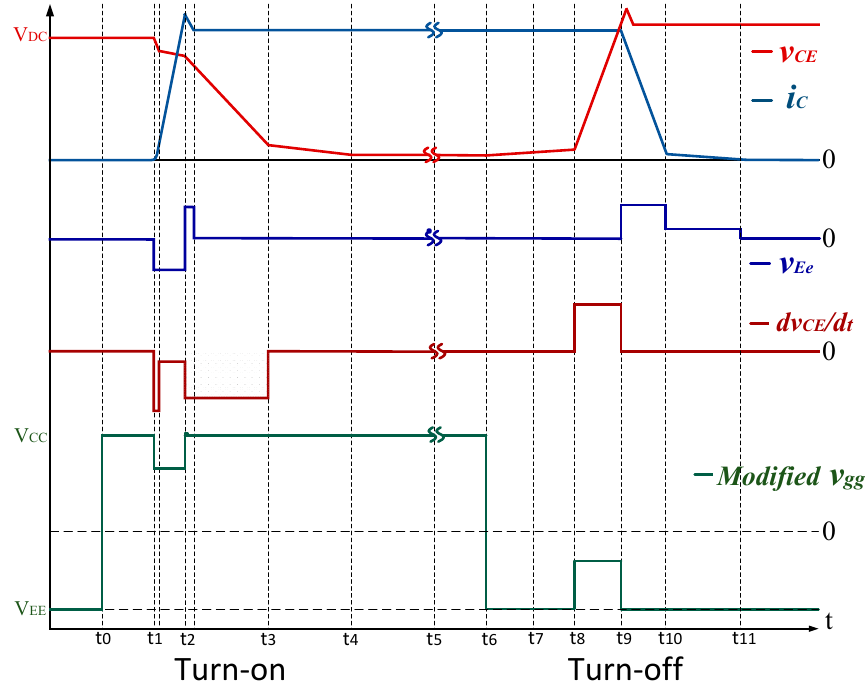
Figure 3. Voltage type feedback signals originated from turn-on and turn-off switching transients and corresponding modified v gg .